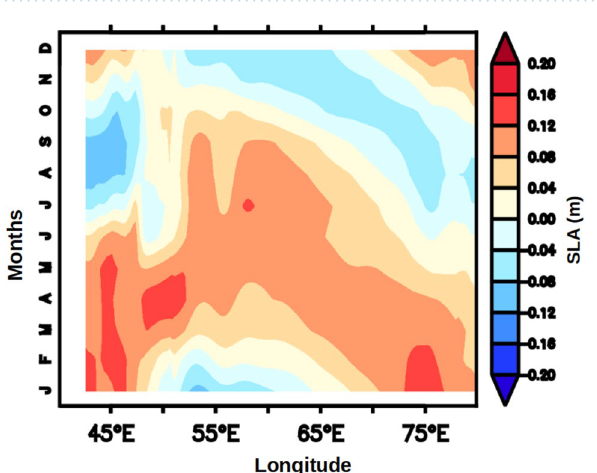
Figure 5. Annual cycle of climatology of UOHC (10 8 kJ/cm 2 ) during ( a ) JJAS, ( b ) ON, ( c ) DJF and ( d ) MAM.